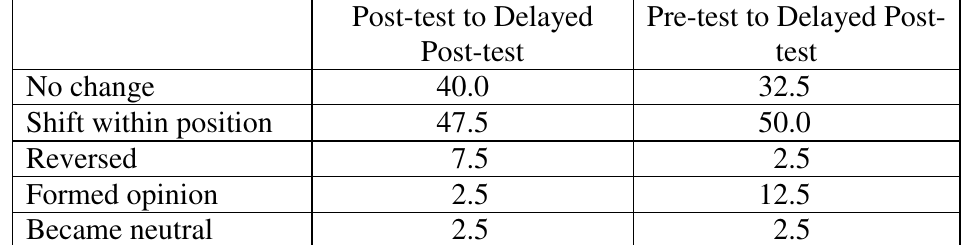
Table 8. Percentage of Participants Exhibiting Changes in Ratings of Nuclear